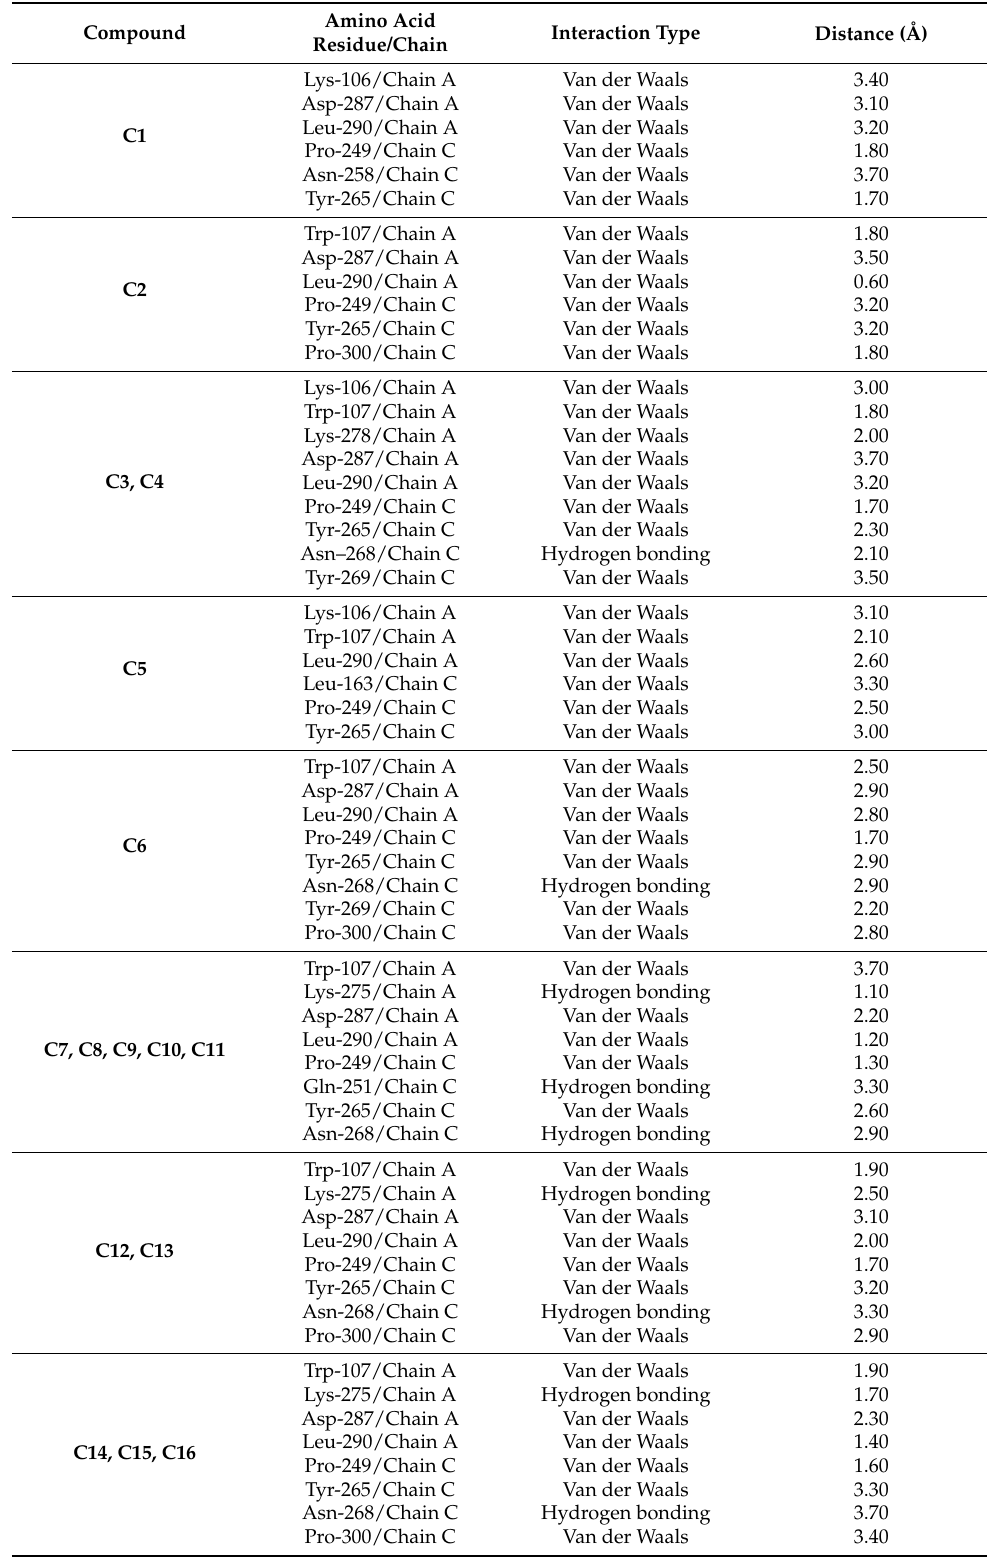
Table 3. Molecular docking results for the interaction between PL pro : C1 – C17